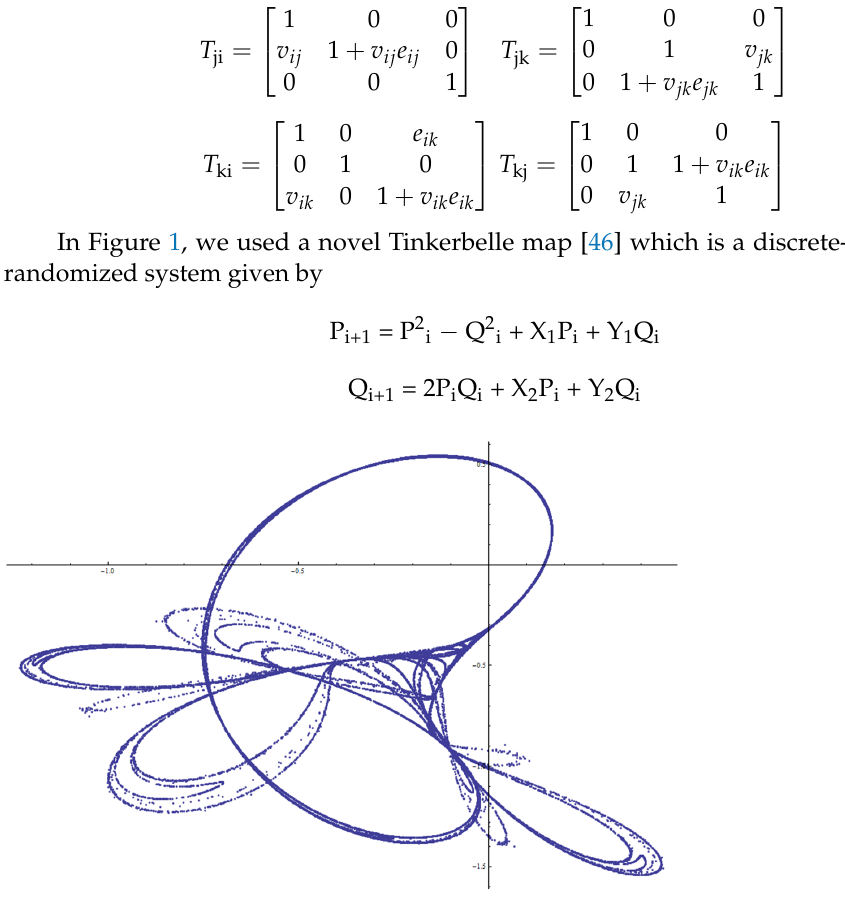
Figure 1. Tinkerbelle Chaotic randomization with X 1 = 0.912 X 2 = ‐ 0.613. Y 1 = 2.01 Y 2 = ‐ 0.52. Used starting values of P 0 = ‐ 0.712 and Q 0 = ‐ 0.63.